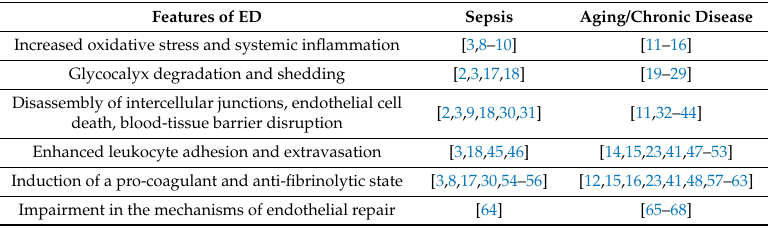
Table 2. References describing the features of endothelial dysfunction